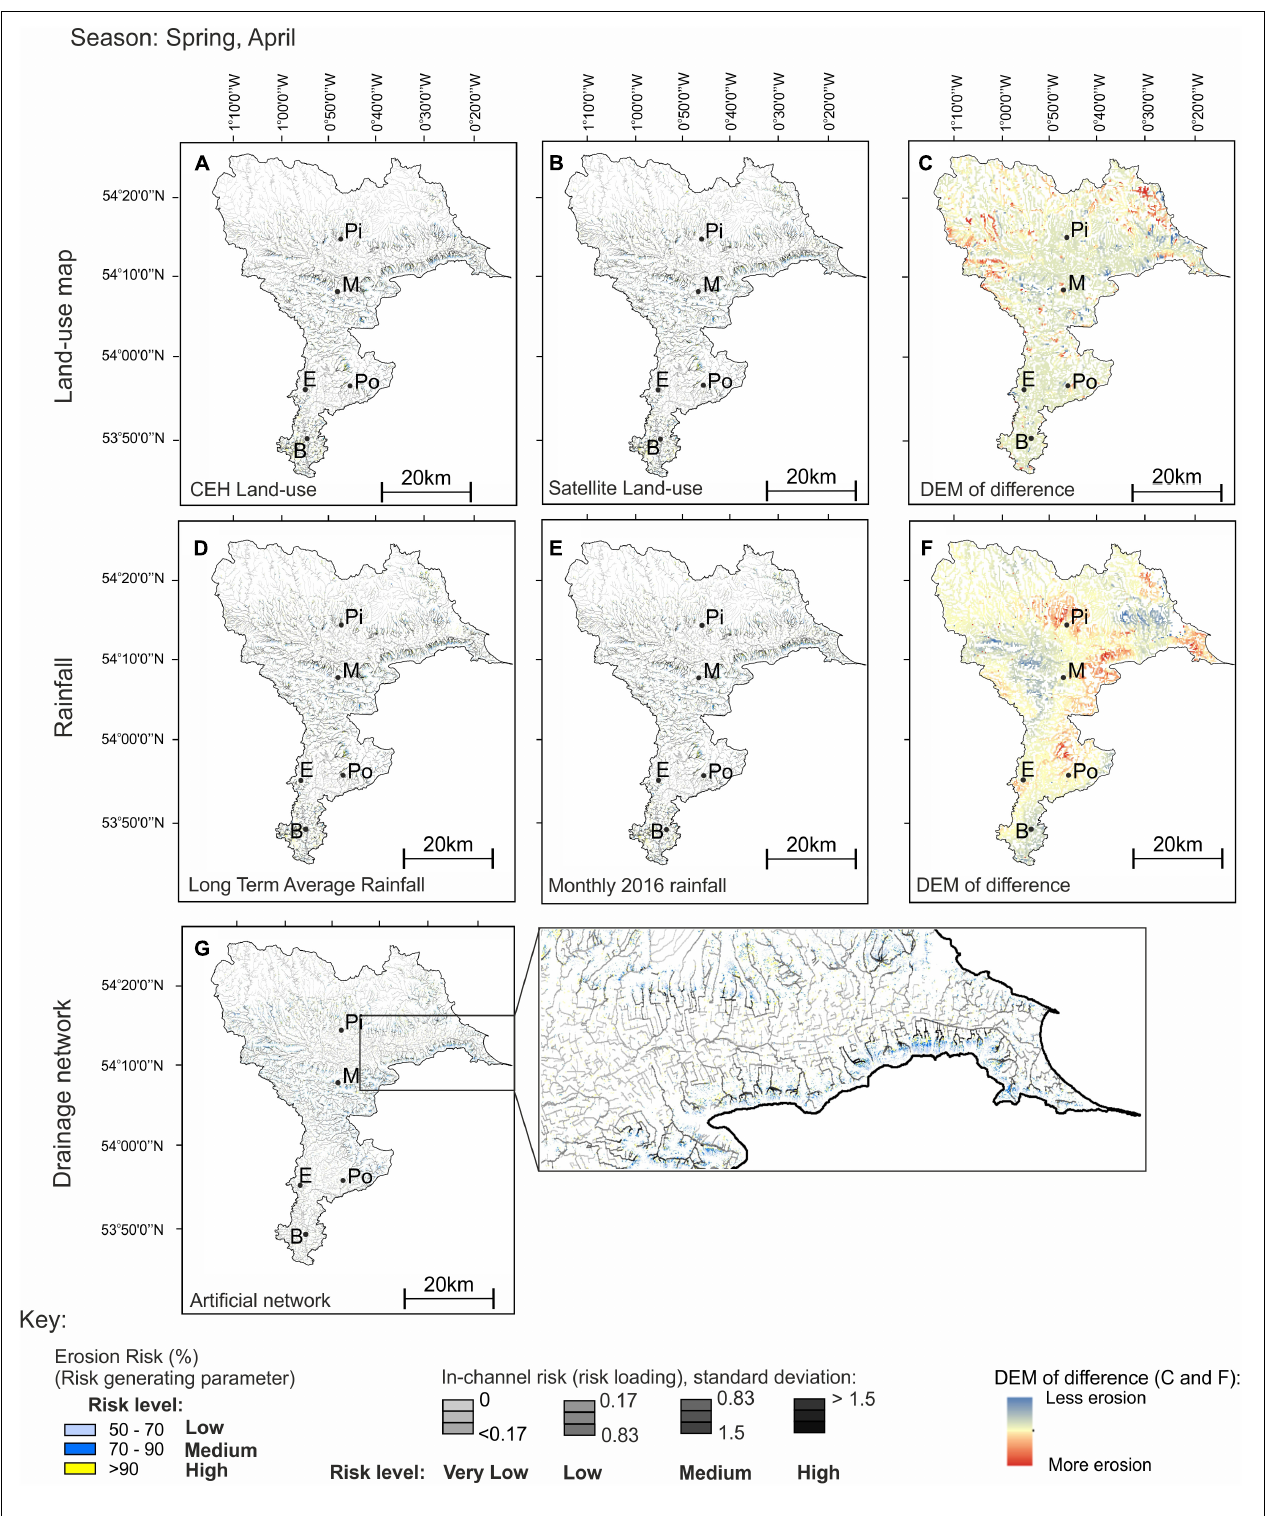
FIGURE 3 | Model scenario outputs for April, (A) CEH land use map; (B) Satellite derived land use map; (C) the DEM of difference between the two land use maps; (D) Long term rainfall average; (E) monthly rainfall totals; (F) the DEM of difference between the two rainfall scenarios; and (G) the artificial drainage network. Locations are shown on each map; Pi, Pickering; M, Malton; Po, Pocklington; E, Elvington; B, Bubwith.